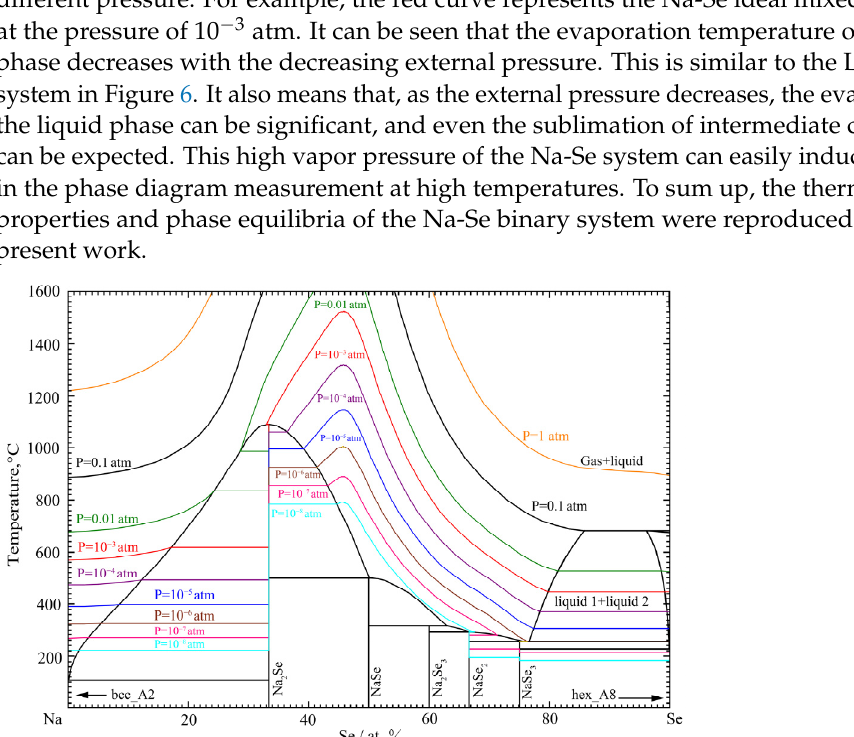
Figure 12. The calculated phase diagram of the Na-Se binary system under different